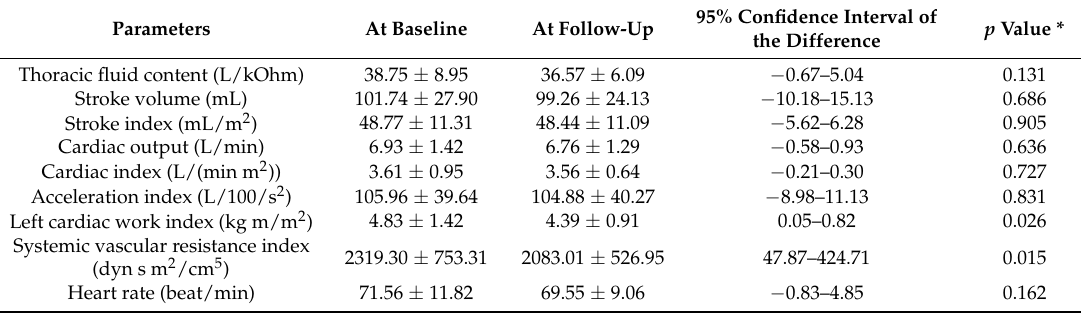
Table 3. Changes of hemodynamic parameters after magnesium supplementation in patients with essential hypertension ( N =